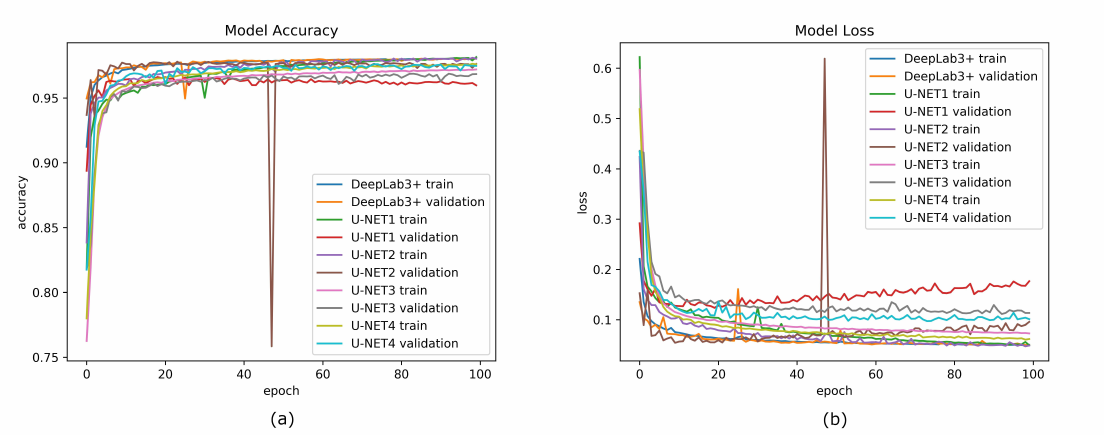
Figure 9. Comparison of metrics evolution over training time of all networks. ( a ) Epochs vs. Accuracy. ( b ) Epochs vs. Loss.